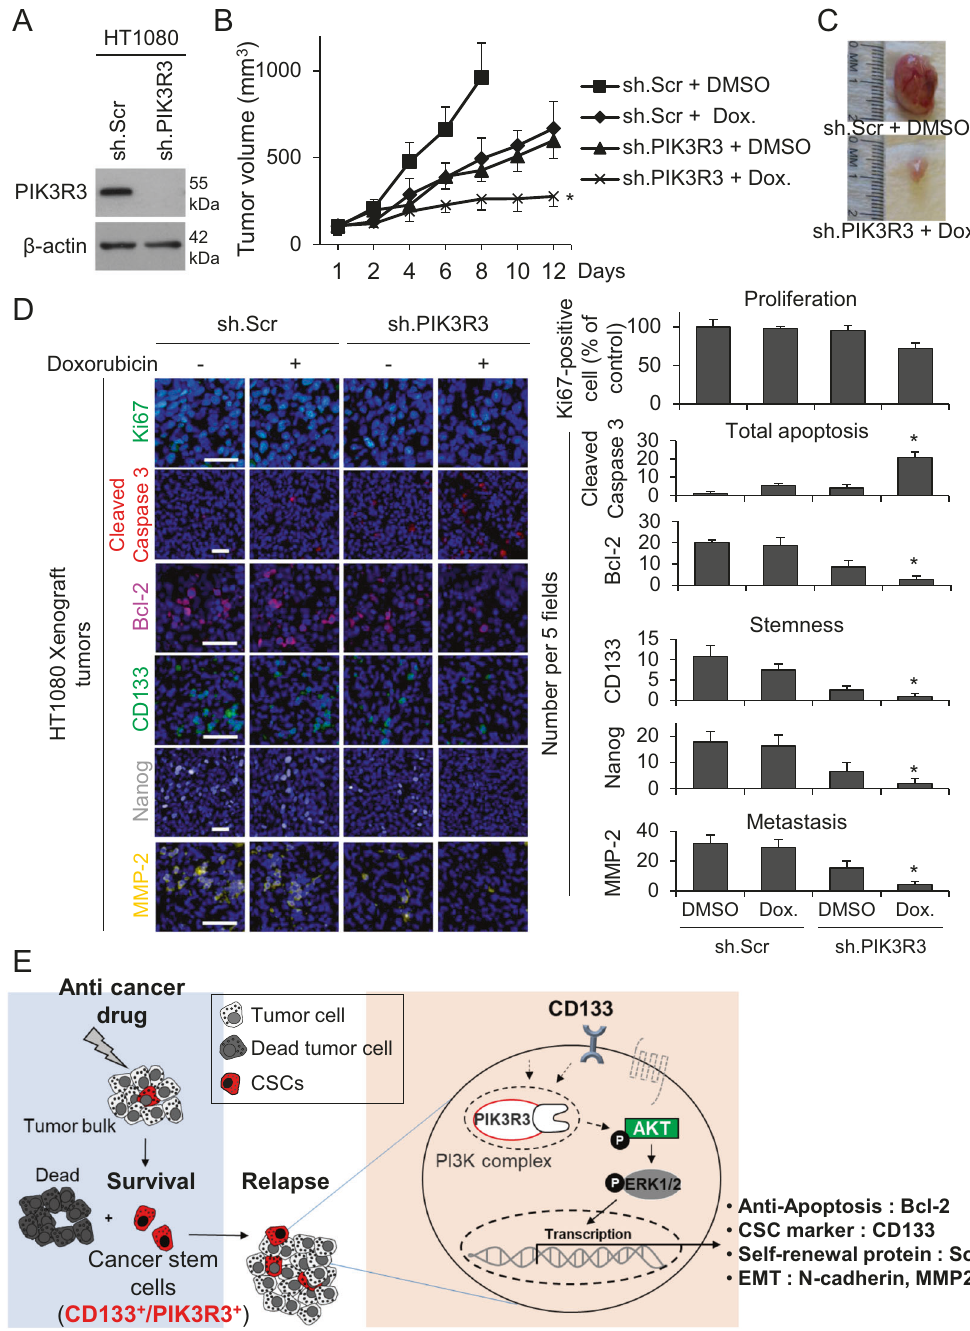
Fig. 6 Eliminating PIK3R3 signaling regulates stemness, malignancy, and chemoresistance in mouse xenograft models. All experiments employ HT1080 fi brosarcoma cells. A Western blot con fi rming knockdown of PIK3R3. β -actin is the loading control. B Growth of xenografts in athymic nude mice following treatment with sh.Scr or sh.PIK3R3 and PBS or doxorubicin. C Photos of representative tumors. D Immuno fl uorescence of tumors for proliferation using Ki-67, apoptosis using cleaved caspase 3, Bcl-2, CD133, Nanog, and MMP-2, with quantitation at right. Scale bar, 50 µm. E A model of the function of PIK3R3 in sarcoma CSCs. * p < 0.01 compared to control.